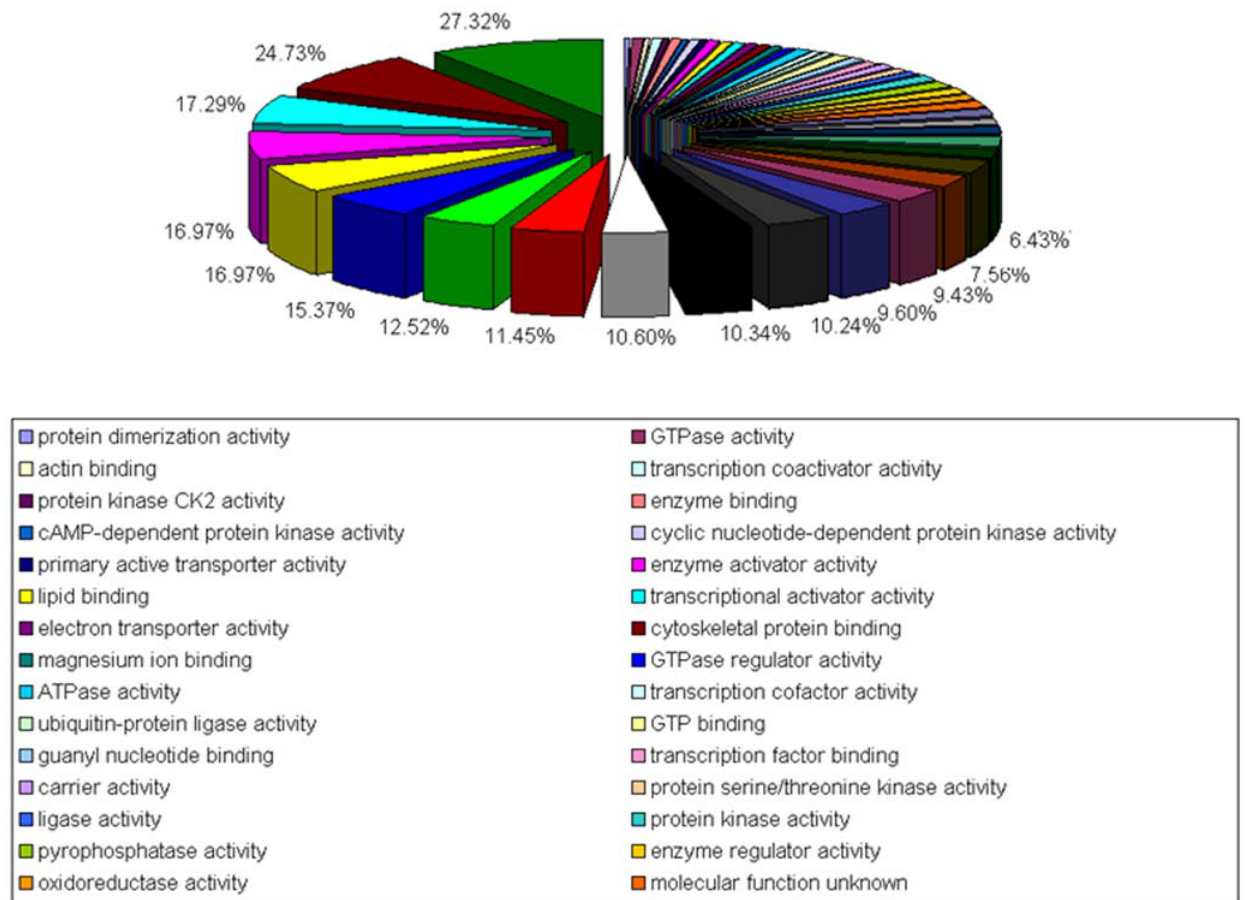
Figure 5. Gene ontology classification for genes common to PAX and PAX – GR. Many genes have multiple gene ontology descriptions.